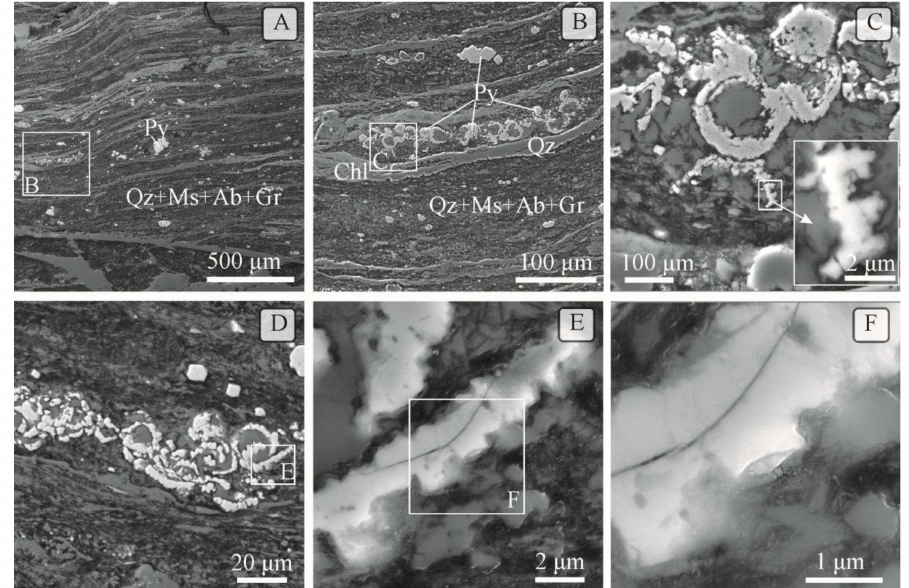
Figure A5. BSE image of pyrite microspheres (vesicular microstructures) and their debris in a car- bonaceous shale, polished section, sample H1-75, the Leksa deposit: ( A , B ) general view of a shale composed of thin layers of quartz, chlorite (chamosite), muscovite, carbonaceous matter and pyrite microsphere accumulations in it. Microspheres and their debris have a complex structure, consisting of individual equant microcrystals ( C , D ), and in some cases it can be assumed that their walls are tubular ( E , F